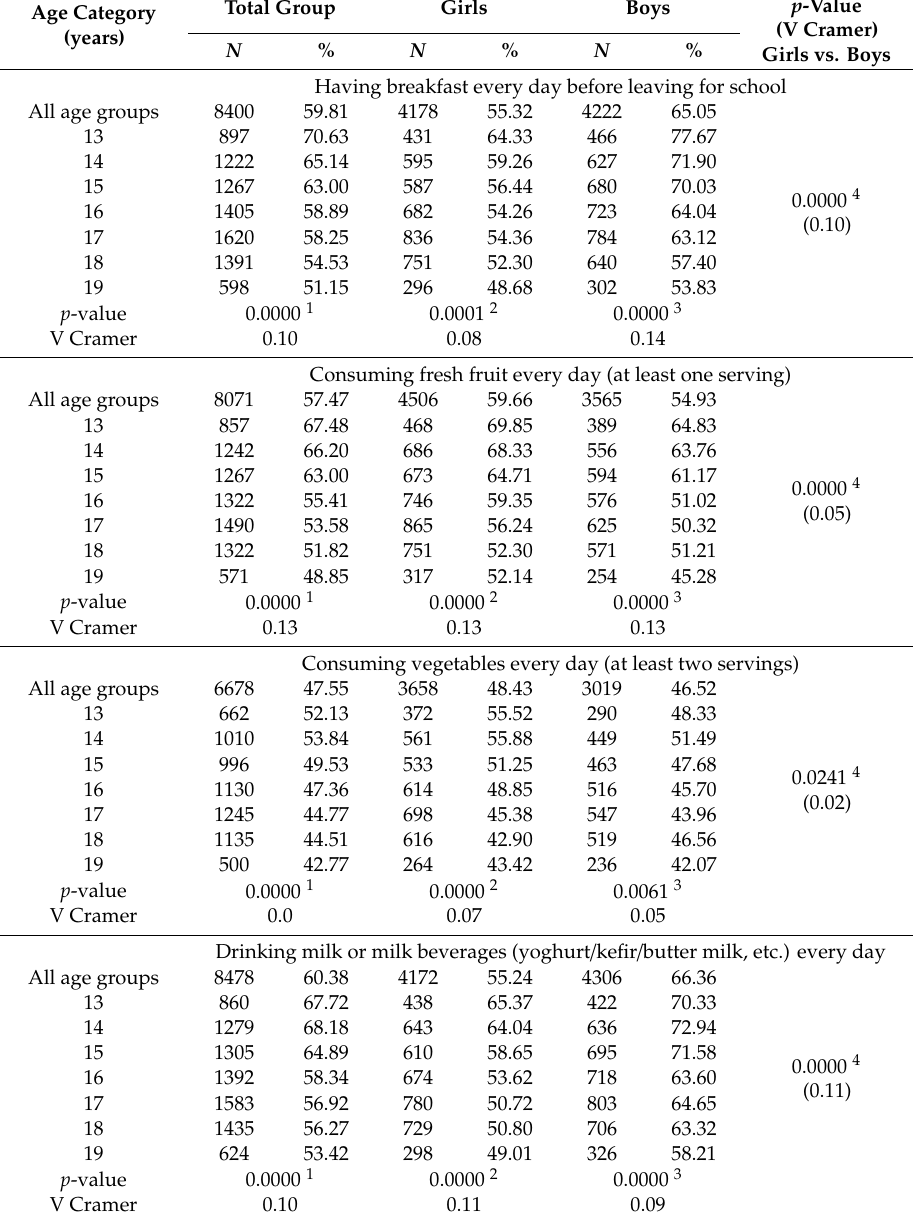
Table 2. Nutritional behaviors of the individuals: In the total group and divided by